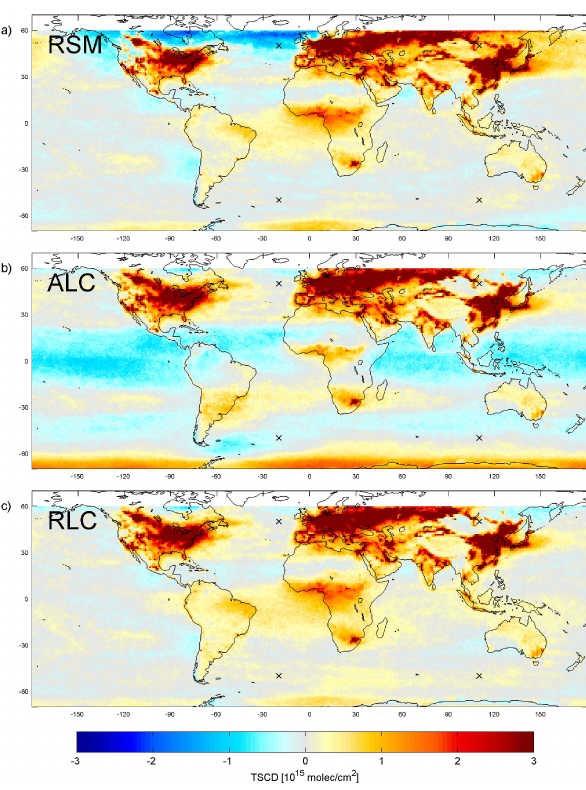
Fig. 8. Difference of mean tropospheric SCDs T RSM − T ALC (a) , T RSM − T RLC (b) , and T RLC − T ALC (c) for January 2003–2008. ± 0 . 3 × 10 15 molec/cm 2 for low latitudes, but can reach ±